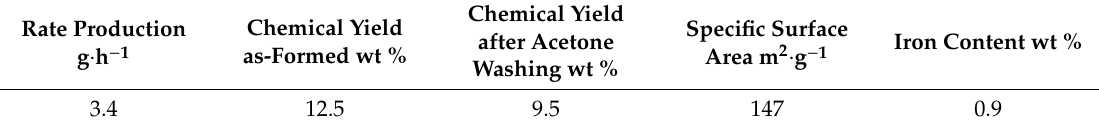
Table 1. Feature of the as-prepared material.